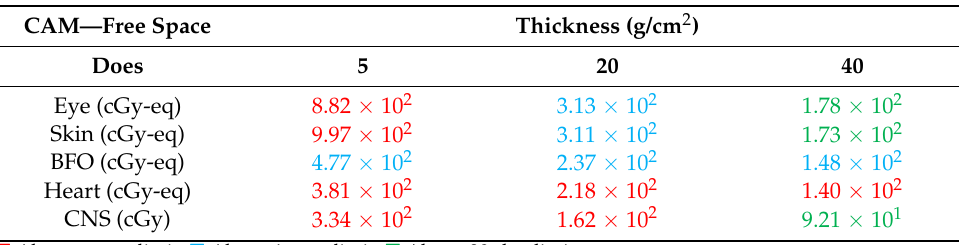
Table 3. Organ doses from 993/4 SPE for CAF on transit to Mars through free space behind various thicknesses of aluminum shielding.